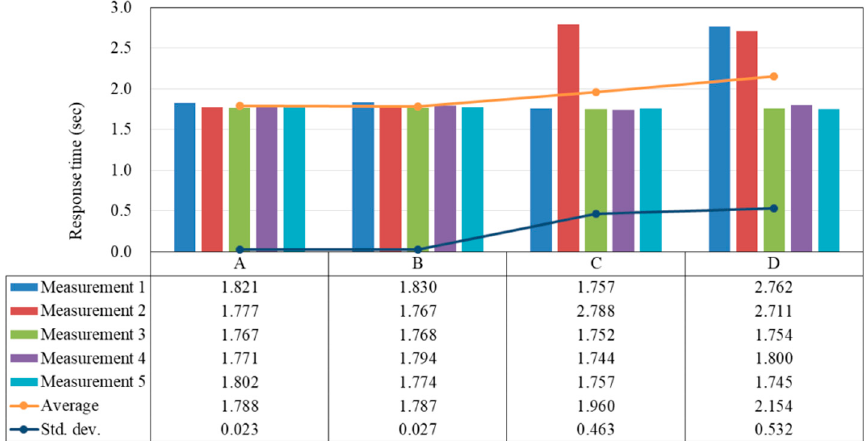
Figure 9. Time taken for the Mobile App to receive the acknowledgement message in Experiment 1 (s).